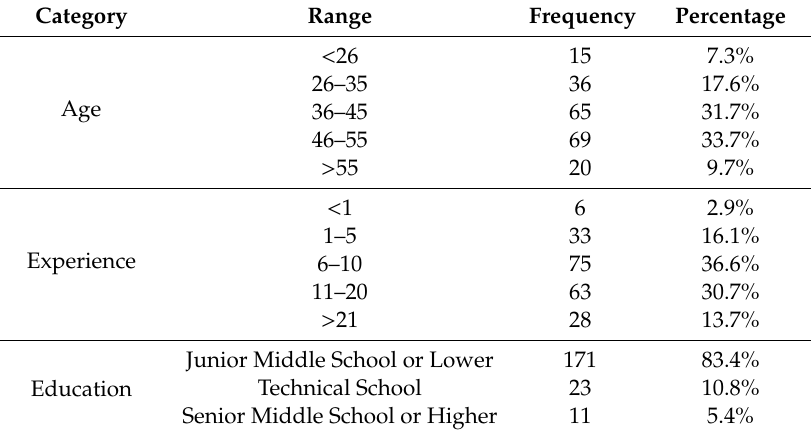
Table 1. The profile of